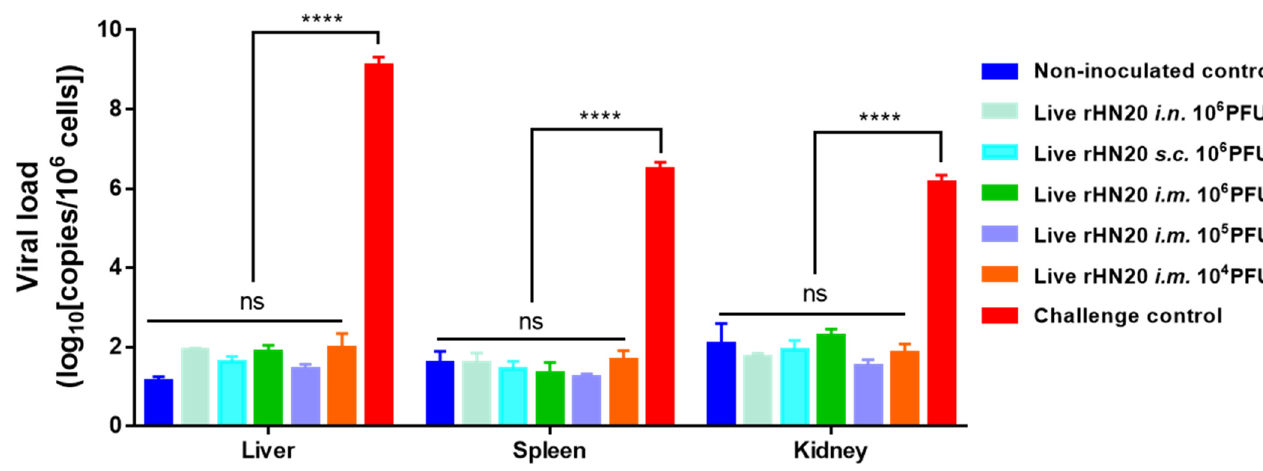
Figure 4. Viral load residues in tissues of chickens in different groups. Surviving chickens were euthanized at 7-days post- challenge for viral load detection using real-time PCR in the liver, spleen, and kidney. Tissues from challenge control group were used as positive controls. Three chickens per group were tested. Error bars represent the SEM. The significance of differences was determined using two-way analysis of variance (****, p < 0.0001, ns, not significant). Routes for immunization were: i.n. = intranasal, s.c. = subcutaneous, and i.m. = intramuscular.